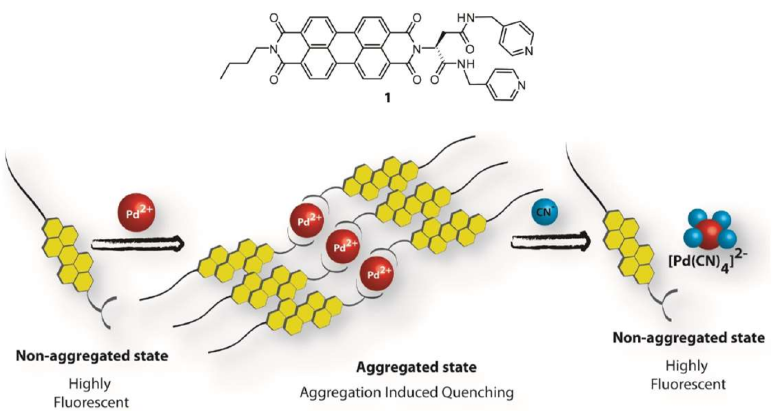
Figure 11. Chemical structure of the PDI sensor probe with a schematic representation of the sensing mechanism of Pd 2+ and CN − ions [82]. Copyright © 2017, Wiley-VCH Verlag GmbH & Co. KGaA,